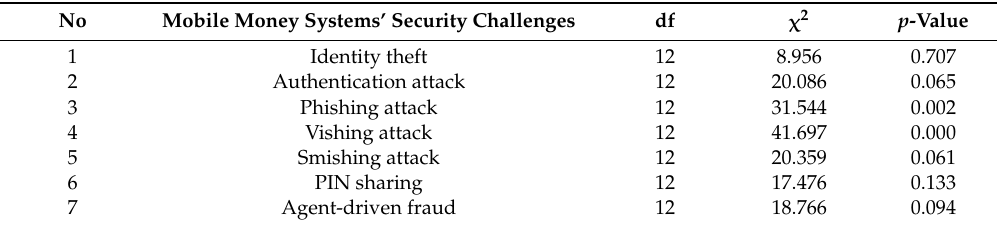
Table 6. Relationship between age and mobile money systems’ security challenges.